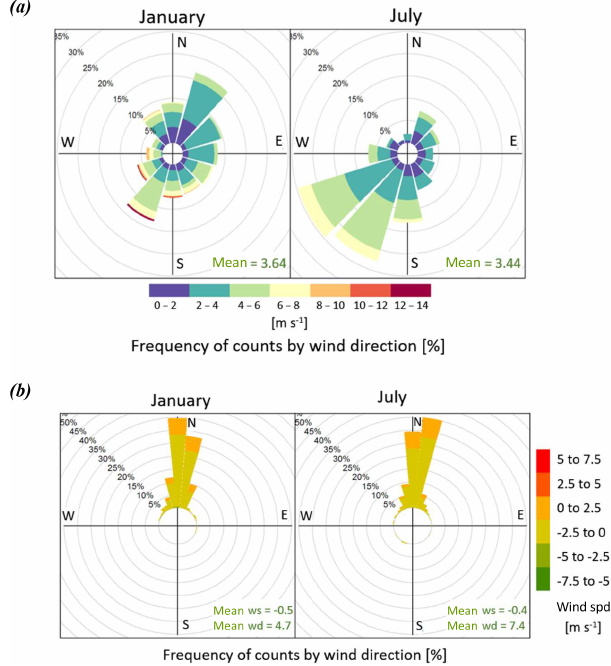
Figure 4. Comparison between measured and modelled winds at Femman station: (a) the observed wind rose in January and July and (b) bias of the wind speed based on the difference between simu- lated wind speed and measured wind speed. For example, a positive bias from 0 to 2.5ms − 1 in wind direction N has a frequency of almost